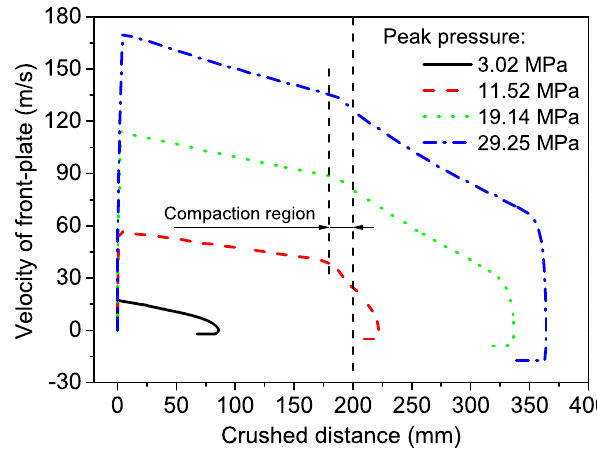
Figure 8. Deformation processes induced from FE simulations. ( a ) Positive gradient specimen, g = 0.3; ( b ) negative gradient specimen, g = − 0.3.